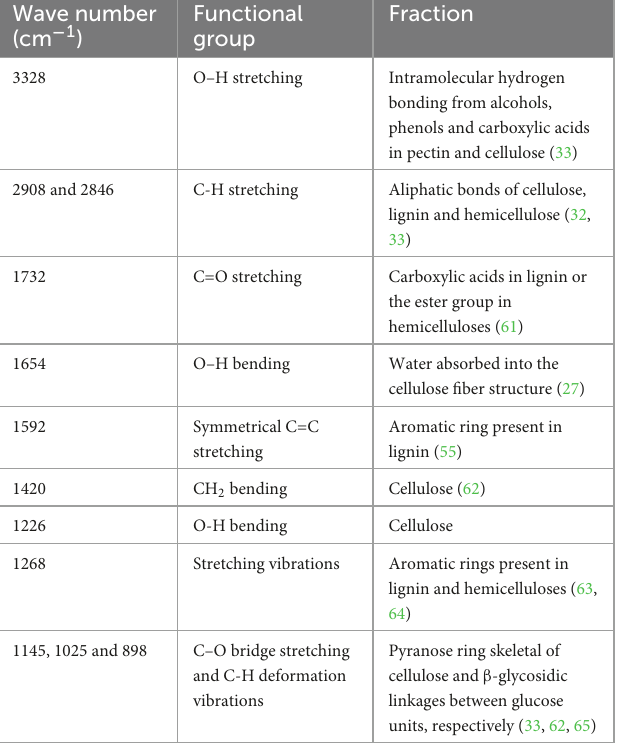
TABLE 4 Characteristic FTIR peaks of raw